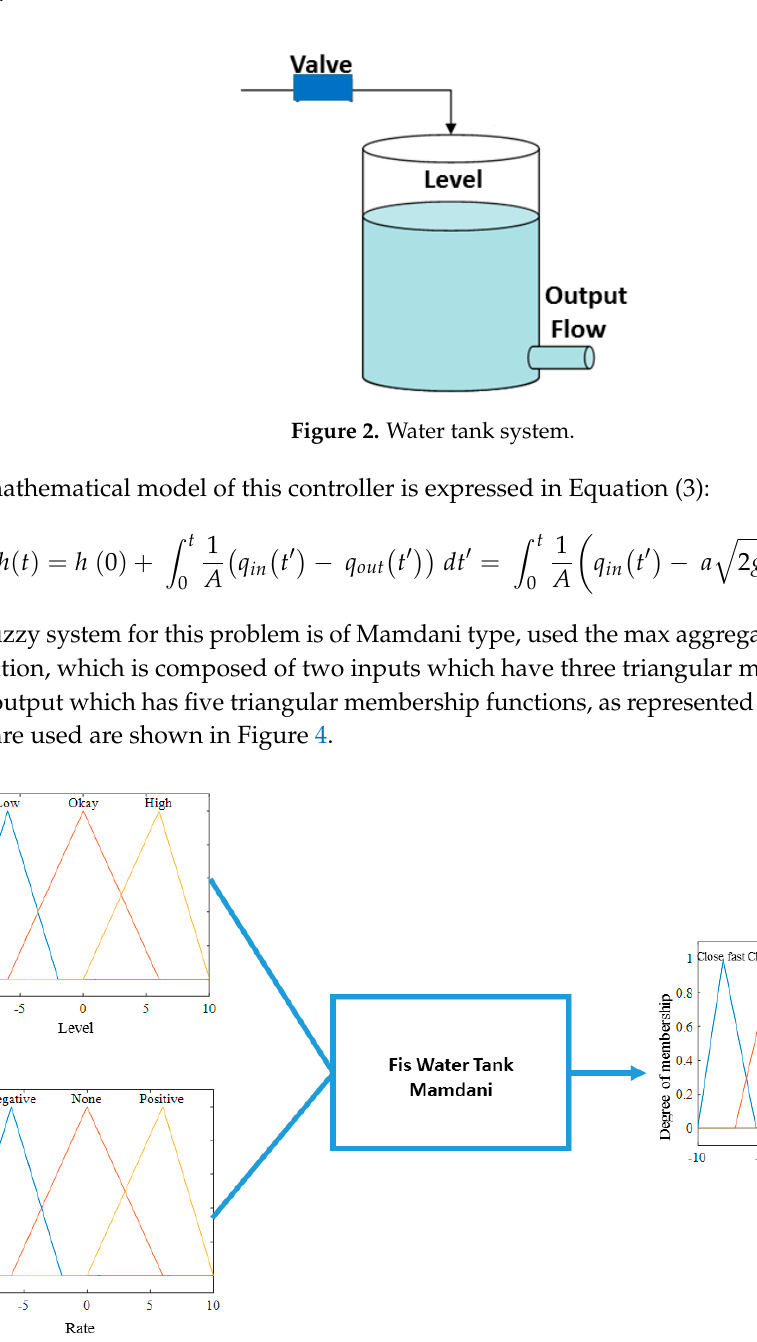
Figure 3. Water tank system.